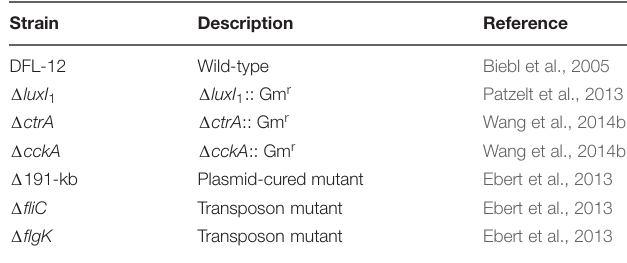
TABLE 1 | Dinoroseobacter shibae strains used in this